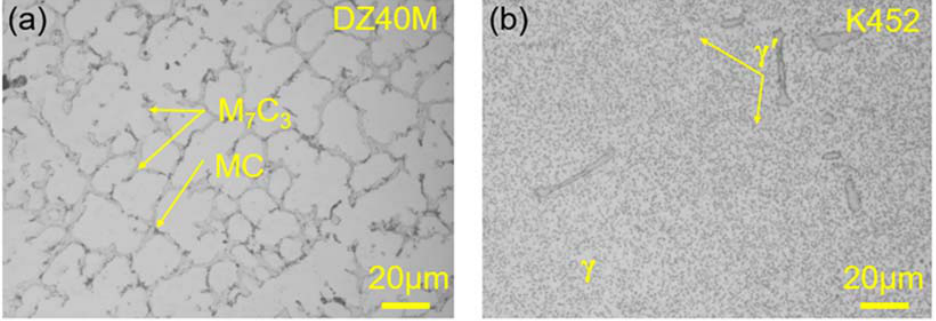
Figure 1. Microstructure of DZ40M and K452. ( a ) Metallographic photograph of DZ40M, ( b ) Metallographic photograph of K452.